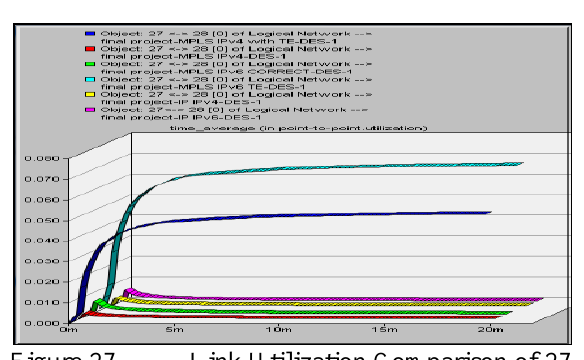
Figure 24 Link Utilization Comparison of IPv6 and MPLS IPv6 along 18 to19 Link